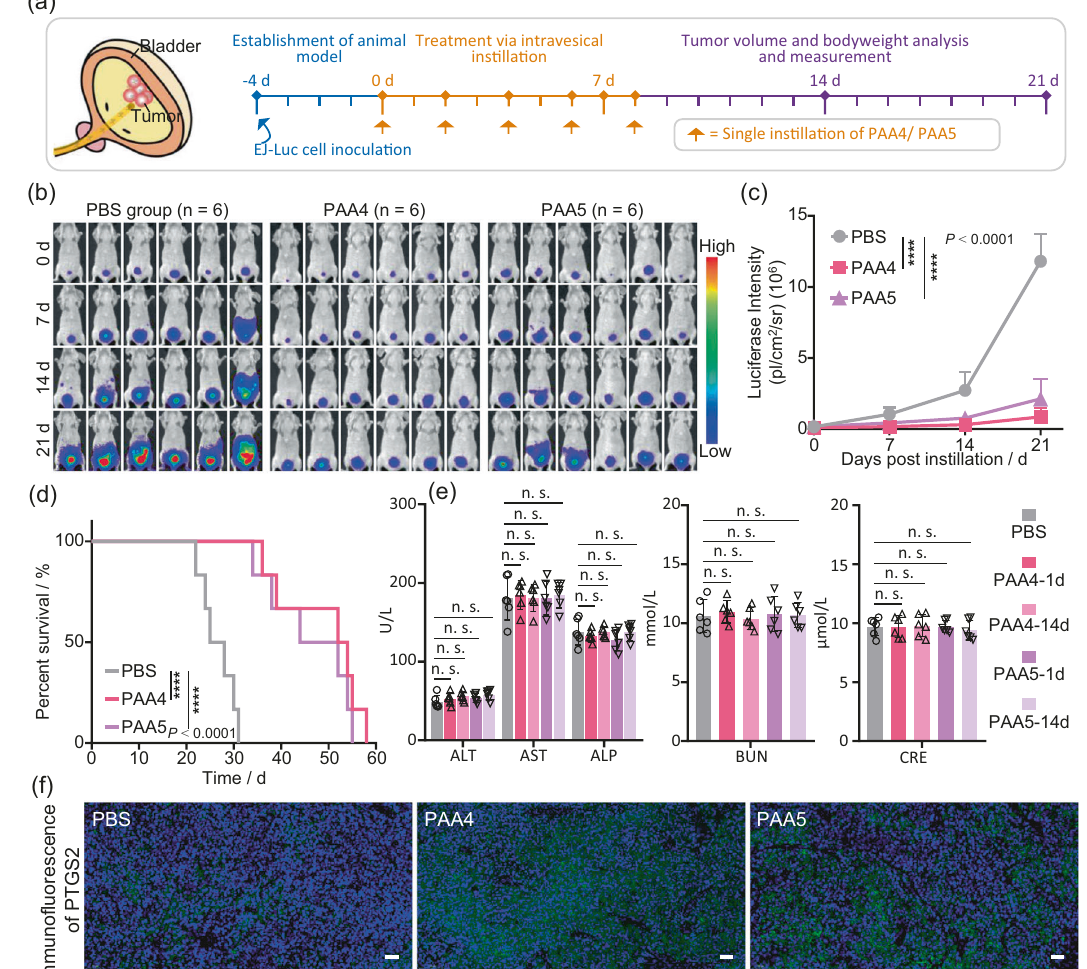
Fig. 6 | In vivo antitumor activity evaluation of PAA4 and PAA5 in orthotopic bladdercancermousemodel.a Left:schematicillustrationofintravesicaldelivery of Au clusters. Right: timeline in treatment and bioluminescence imaging of orthotopic bladder cancer mice. b In vivo bioluminescence images of orthotopic bladdercancermiceatdifferentdaysafterthetreatmentwithPBS, PAA4 and PAA5 (1.5 μ M, 100 μ L, 60min). c Quantitative bioluminescence intensity of luciferase in orthotopic bladder tumor. The statistical comparison tumor growth curve was calculatedonday21. d Kaplan – MeiersurvivalcurveofEJorthotopicbladdercancer nude mice. e Blood biochemistry data of the mice after the treatment with Saline, PAA4 and PAA5 , respectively, in the aspects of major indicators of liver function